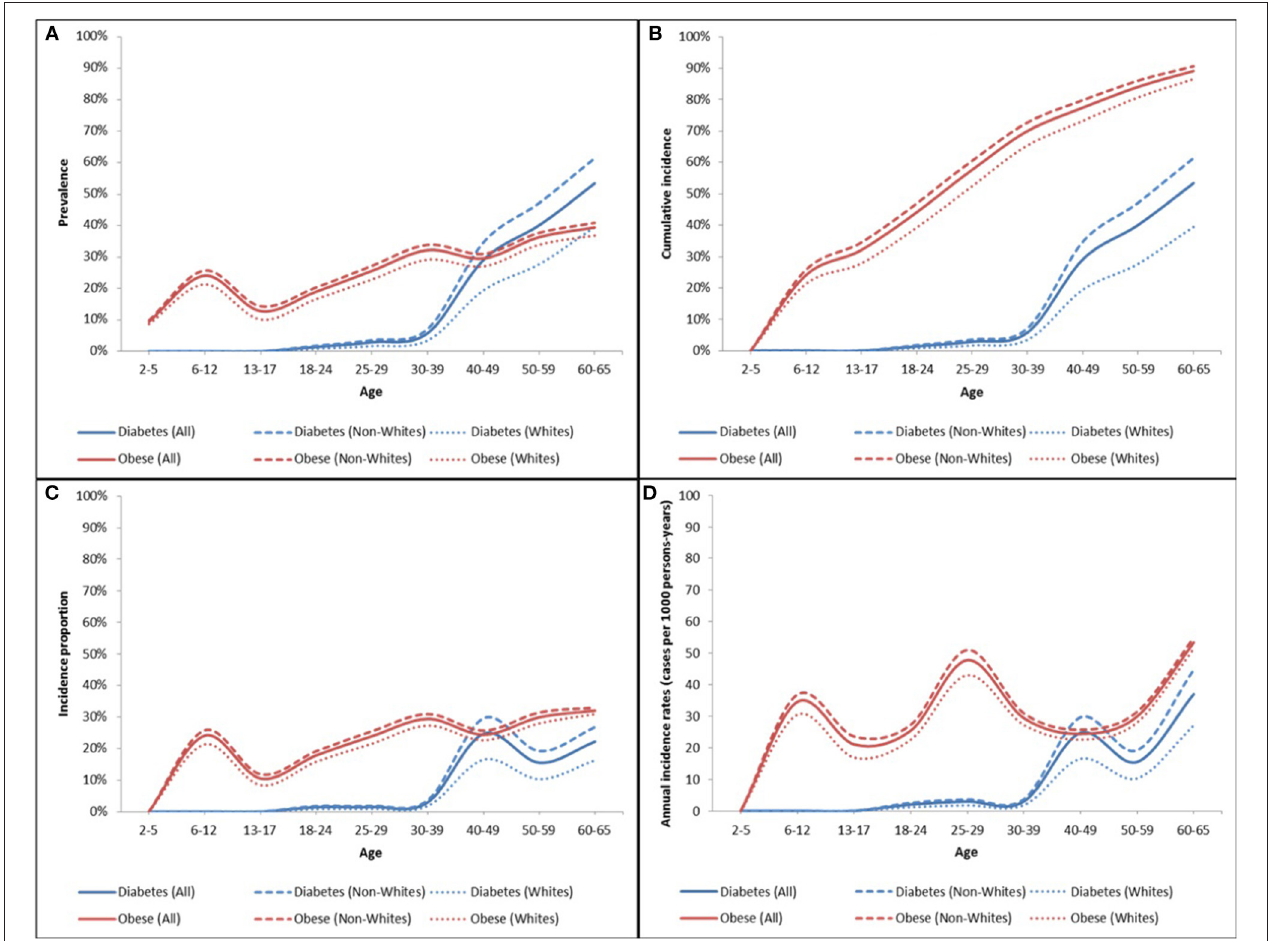
FIGURE 5 | Obesity and type 2 diabetes prevalence (A) , cumulative incidence (B) , age-specific incidence proportion (C) , and annual incidence rates (D) in the ViLA-Obesity model. The incidence measures were calculated for first-time diagnosis of obesity or type 2 diabetes among at-risk individuals (i.e., without the diagnosis).